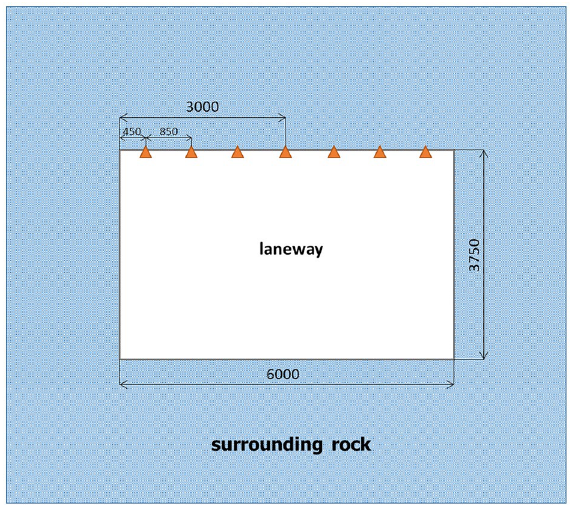
Figure 8. Cloud diagram of deformation of surrounding rock of roadway: ( a ) Cloud image of deformation of surrounding rock without support; ( b ) Cloud image of deformation of surrounding rock with support.